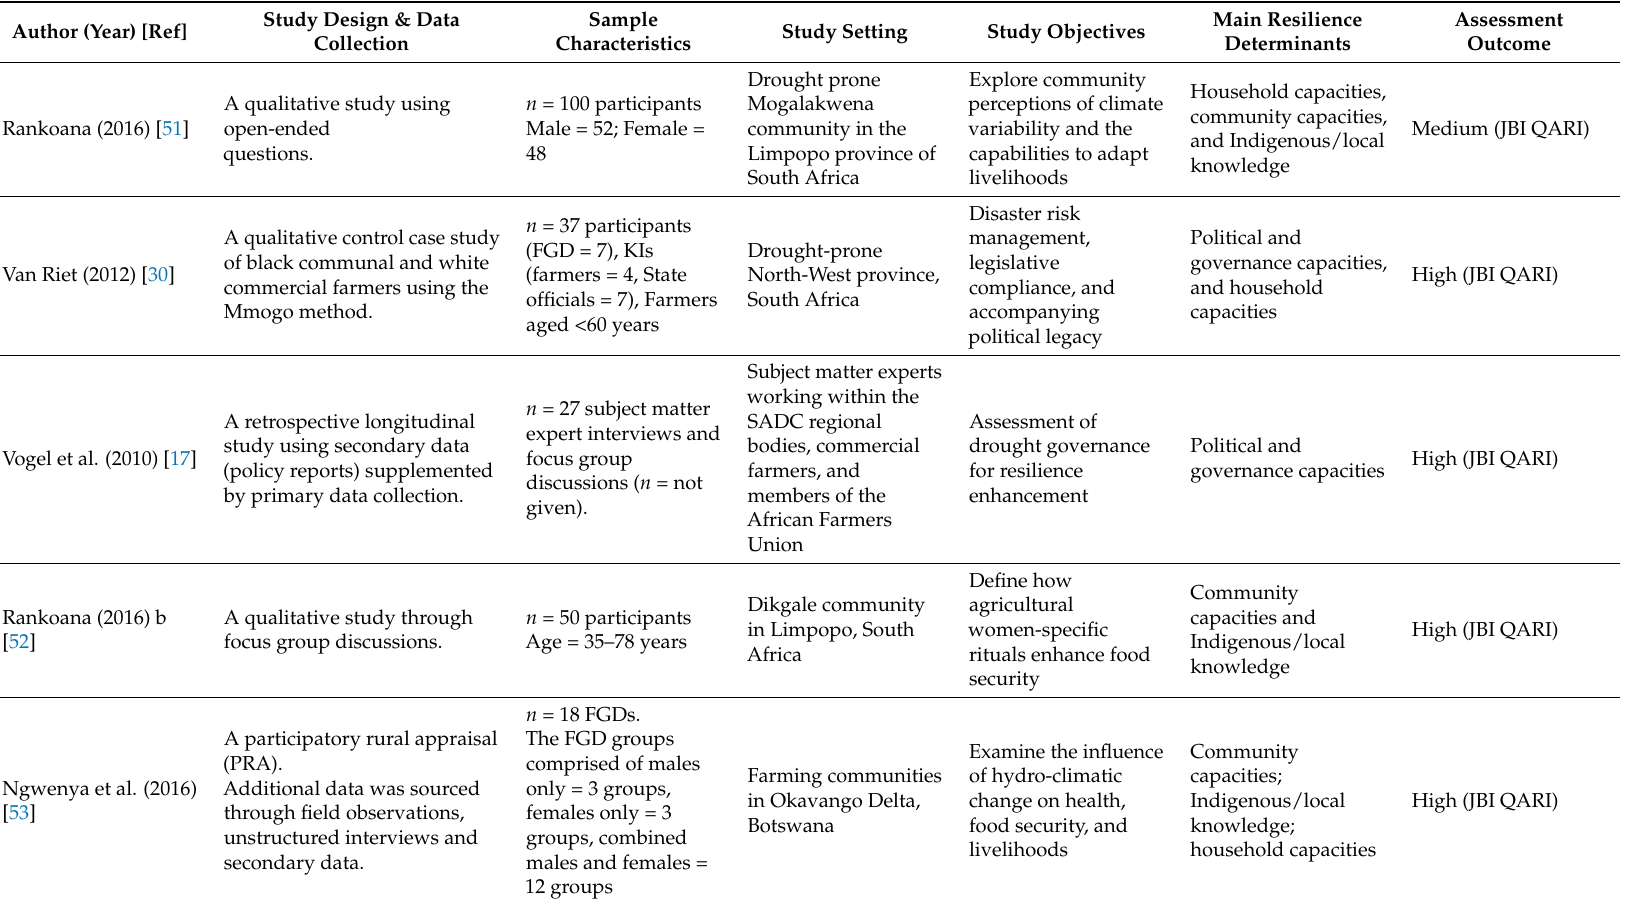
Table 1. The study